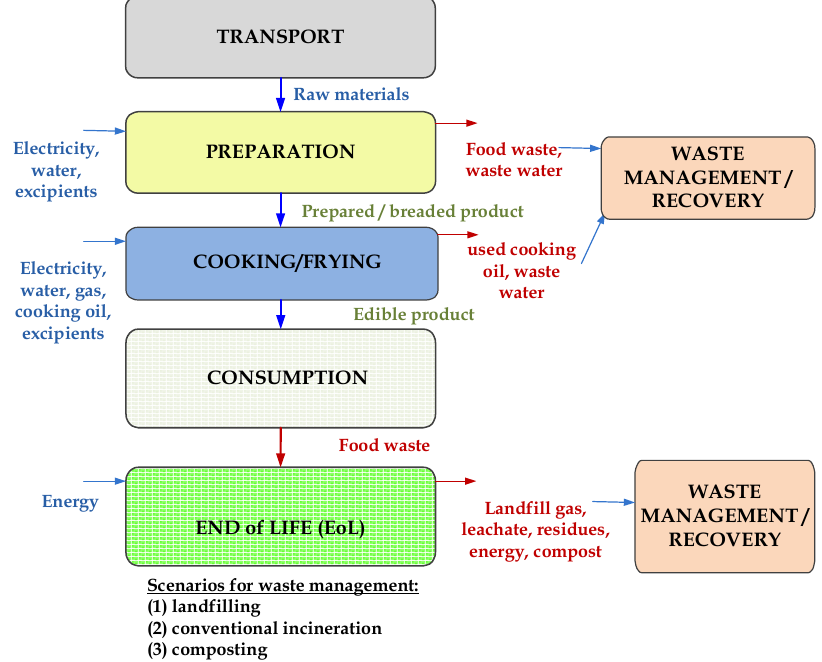
Figure 1. LCA phases of the product (self-edited